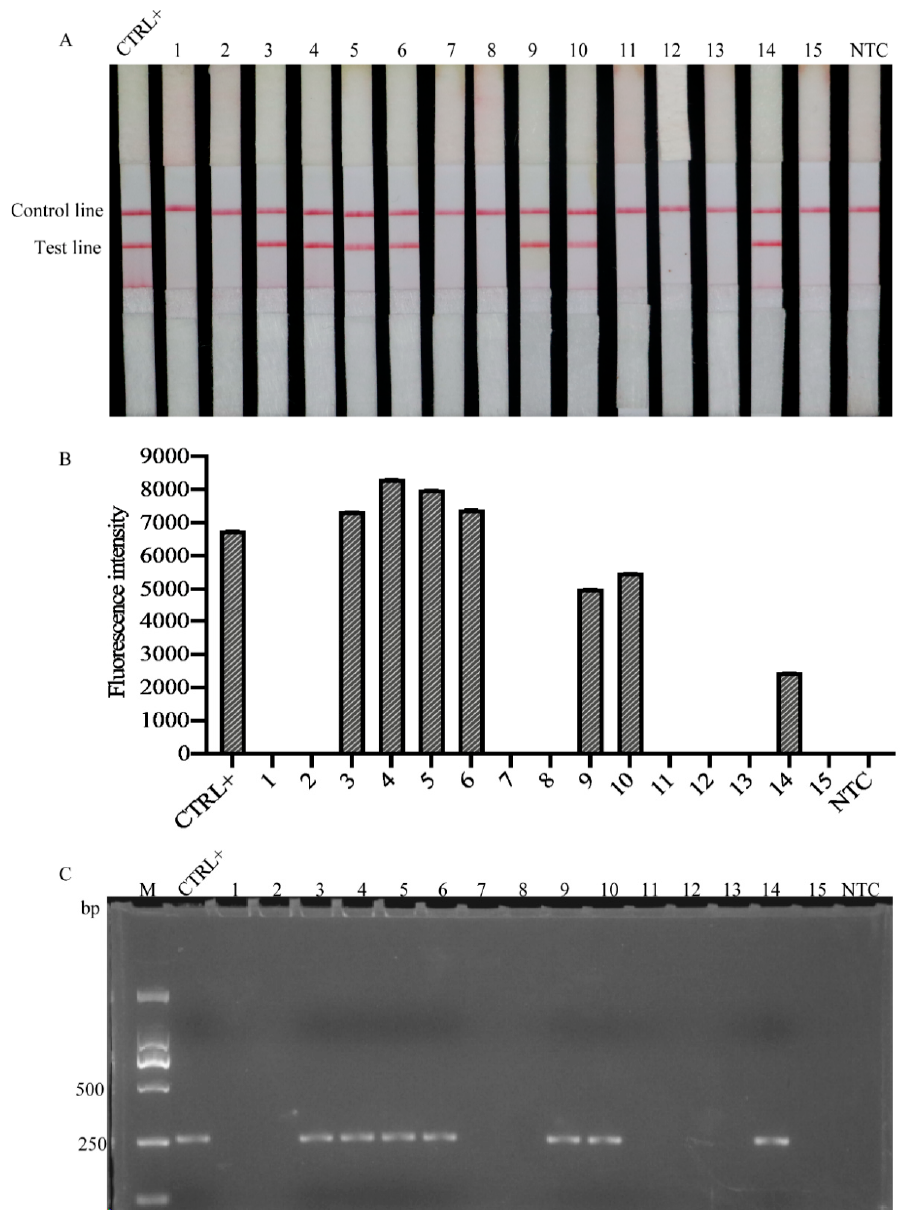
Figure 6. Detection of H. schachtii in natural field samples using the RPA assay and conventional PCR. ( A ) LFD test strip results. ( B ) RPA/CRISPR results. ( C ) Conventional PCR results. M, D2000 marker; CTRL+, positive control containing H. schachtii DNA; NTC, no template was added as a negative control. The presence of two lines indicates a positive result.